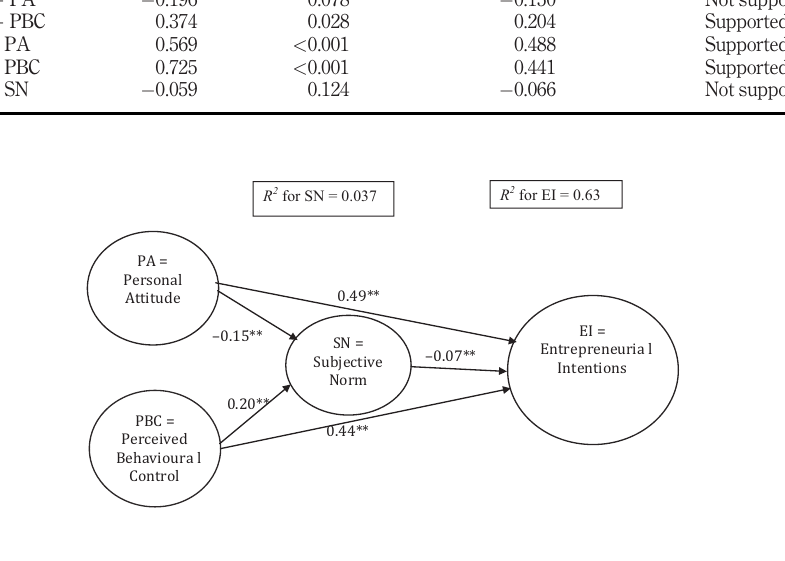
Table VII. Structural path analysis (hypotheses testing)